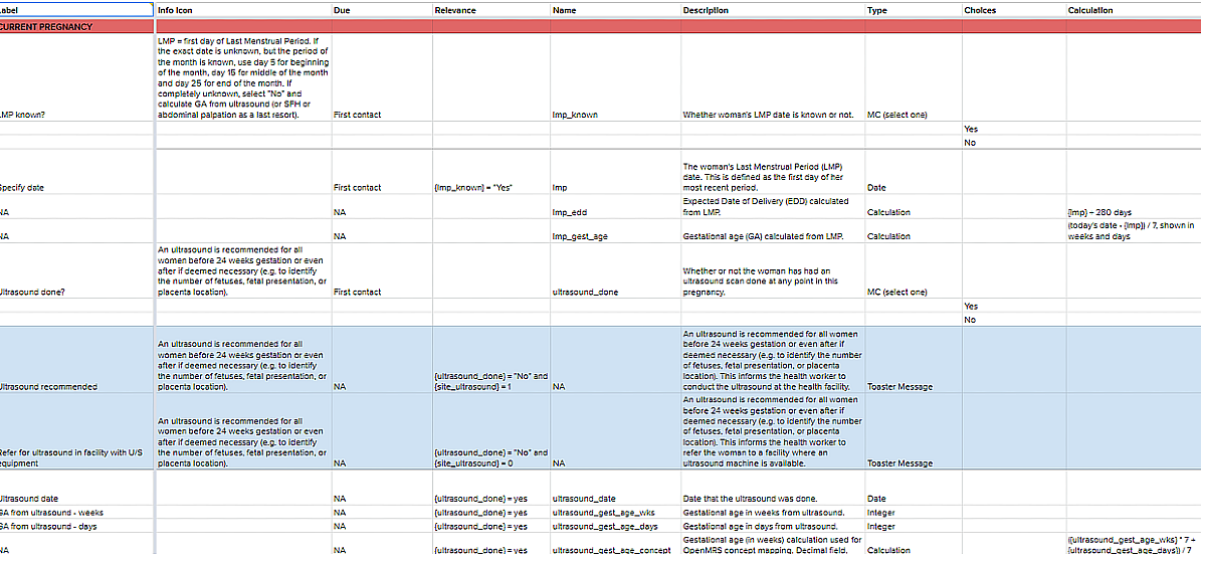
Figure 5. Data Dictionary - Profile Tab. ANC: antenatal care; GA: gestational age; HIV: human immunodeficiency viruses, LMP: last menstrual